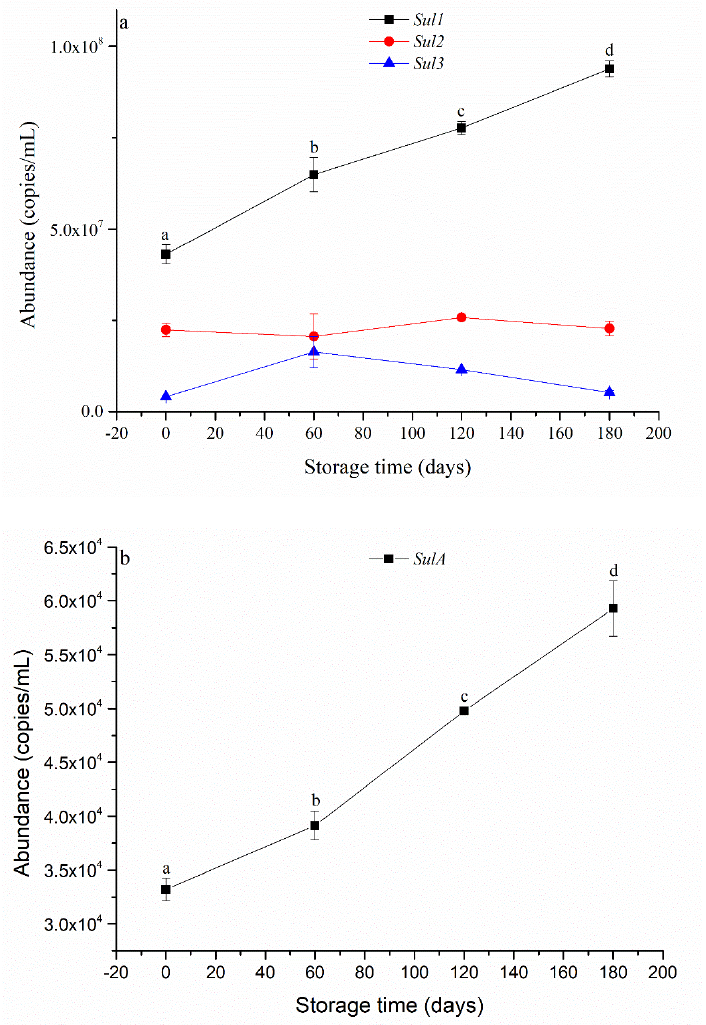
Figure 4. The abundances of Sul1 , Sul2 , and Sul3 ( a ); and SulA ( b ) in swine wastewater at different storage times. Data shown are the means of three replicates, and different letters indicate signifi ‐ cance at p <